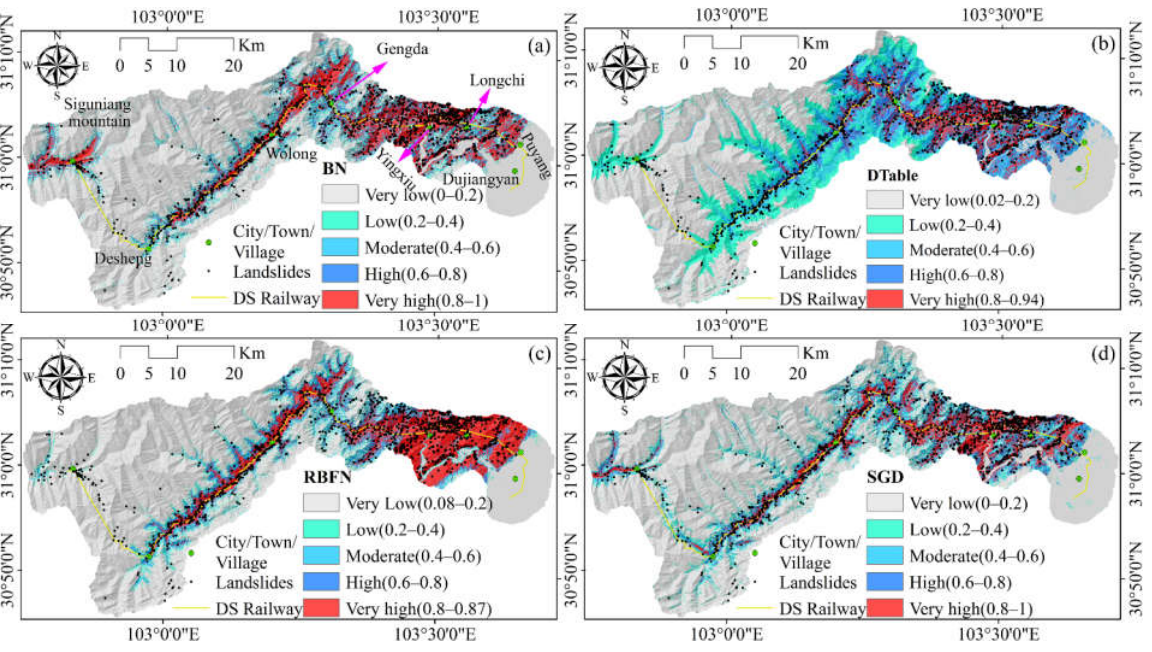
Figure 7. LSMs for the study area produced by the ( a ) BN model, ( b ) DTable model, ( c ) RBFN model, and ( d ) SGD model.